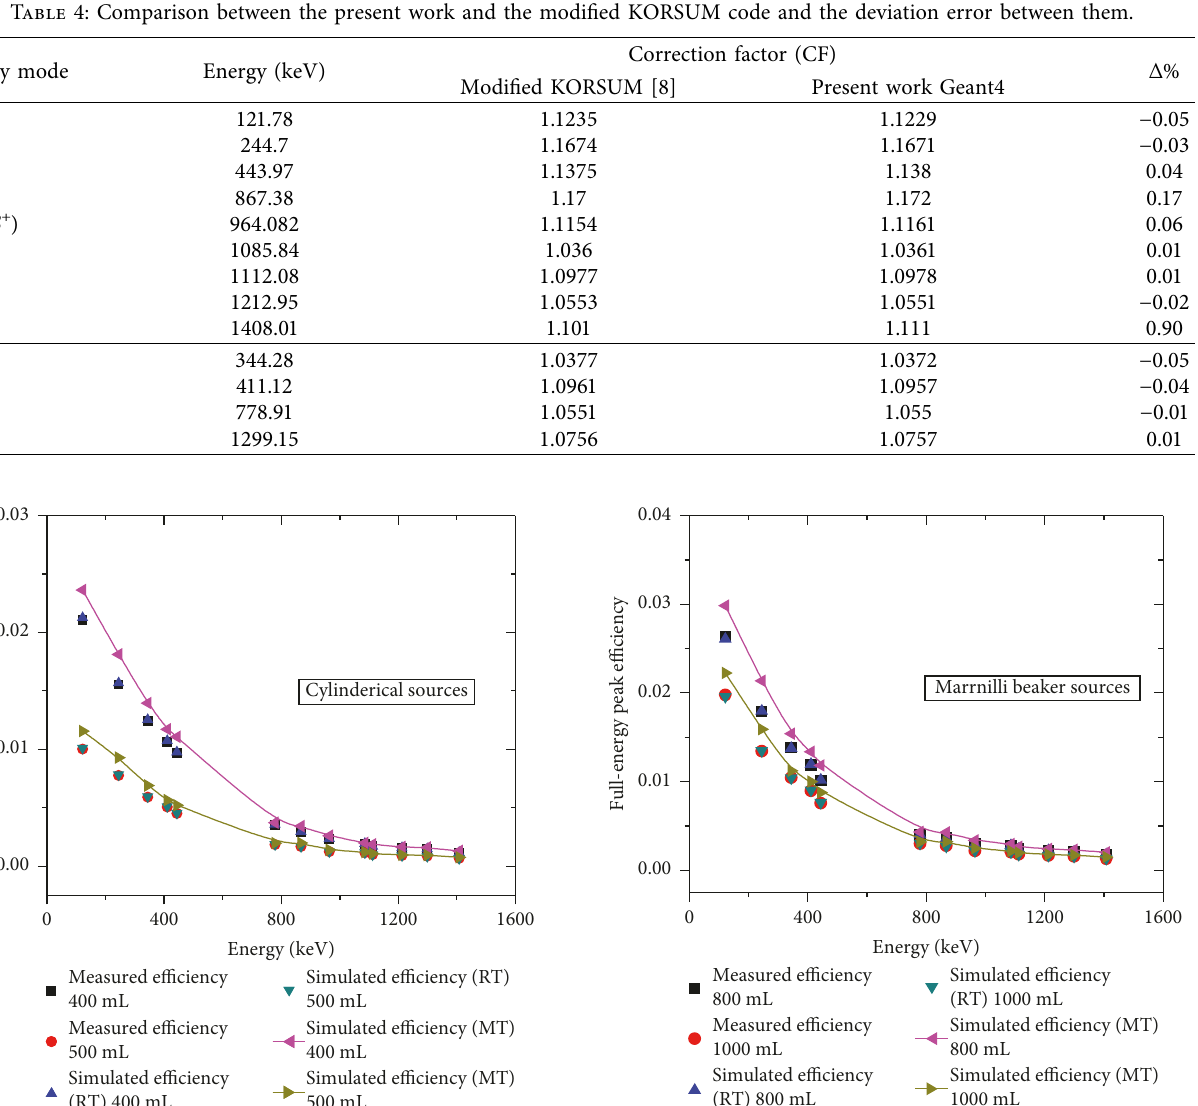
Figure 9: The experimental, simulated RT, and simulated MTfull- energy peak efficiency for different Marinelli beaker volumetric 152 Eu sources as a function of different c -ray energies.